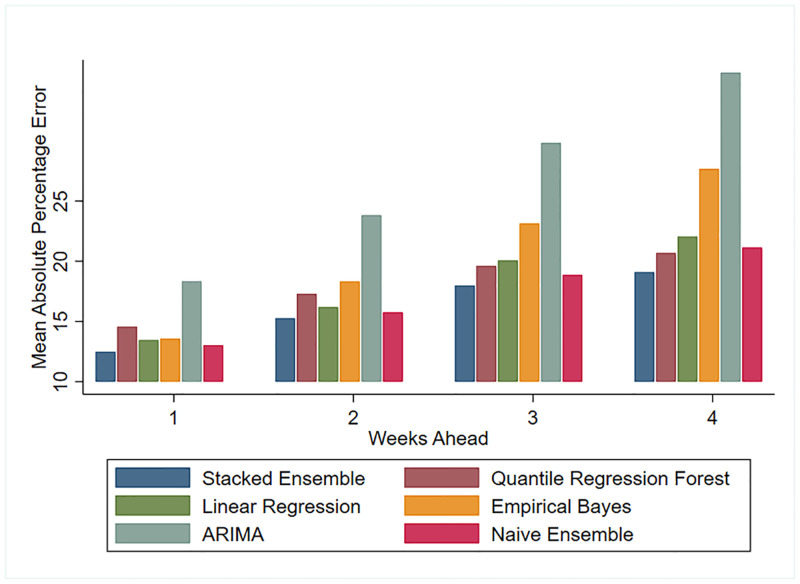
MAPE comparison for test seasons 2012-2018.